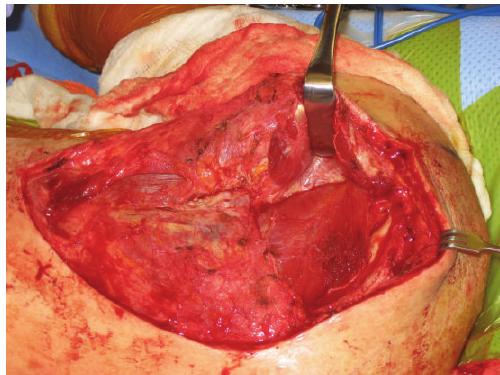
Figure 8: The deltoid origin is sharply released from the scapular spine, and the deltoid is retracted laterally.